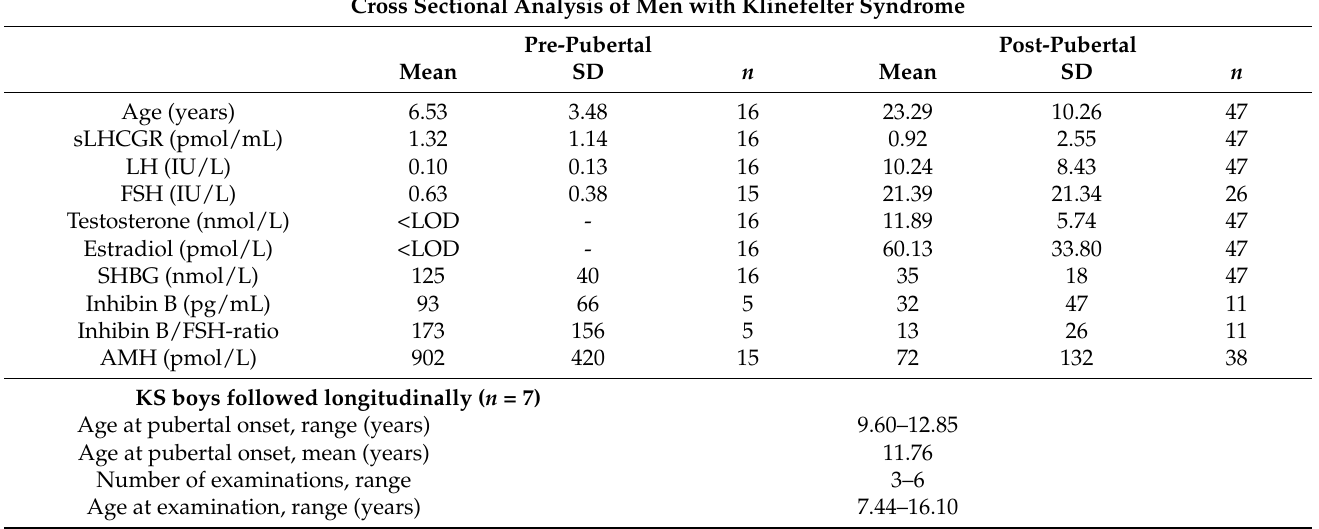
Table 3. Baseline characteristics of 63 boys and men with Klinefelter Syndrome, seven boys were further followed longitudinally. LOD = limit of